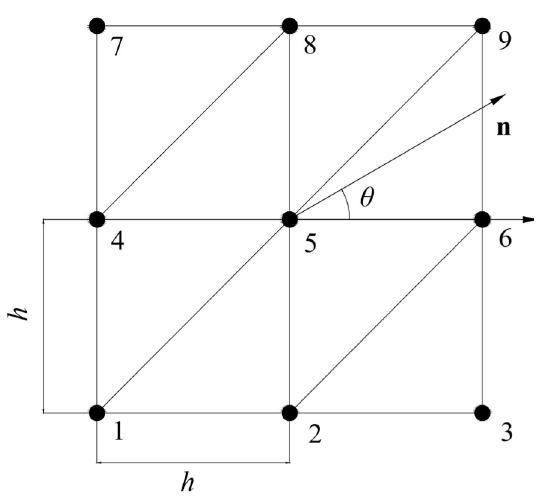
Figure 2. The employed regular triangular mesh pa tt ern to investigate the dispersion e ff ects.